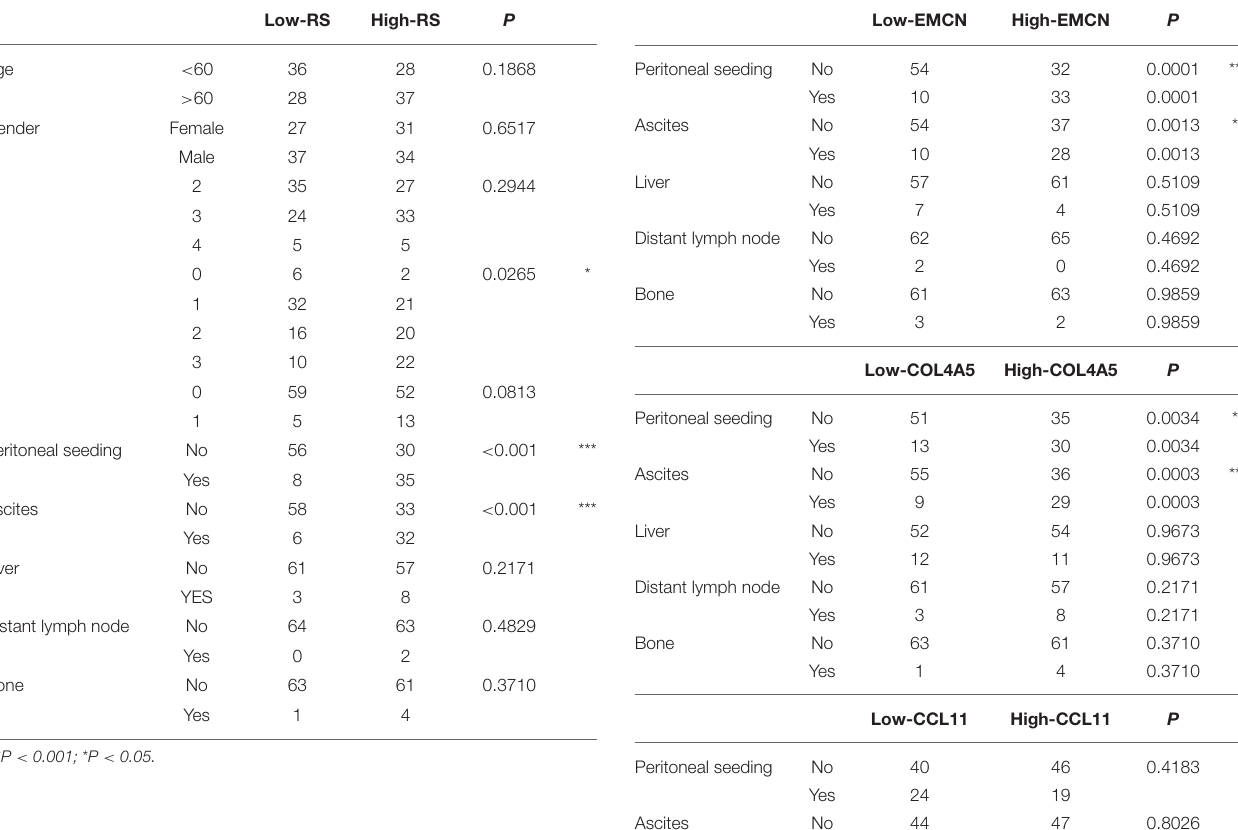
TABLE 3 | The correlation between RS and clinical pathological parameters in diffuse type GC.